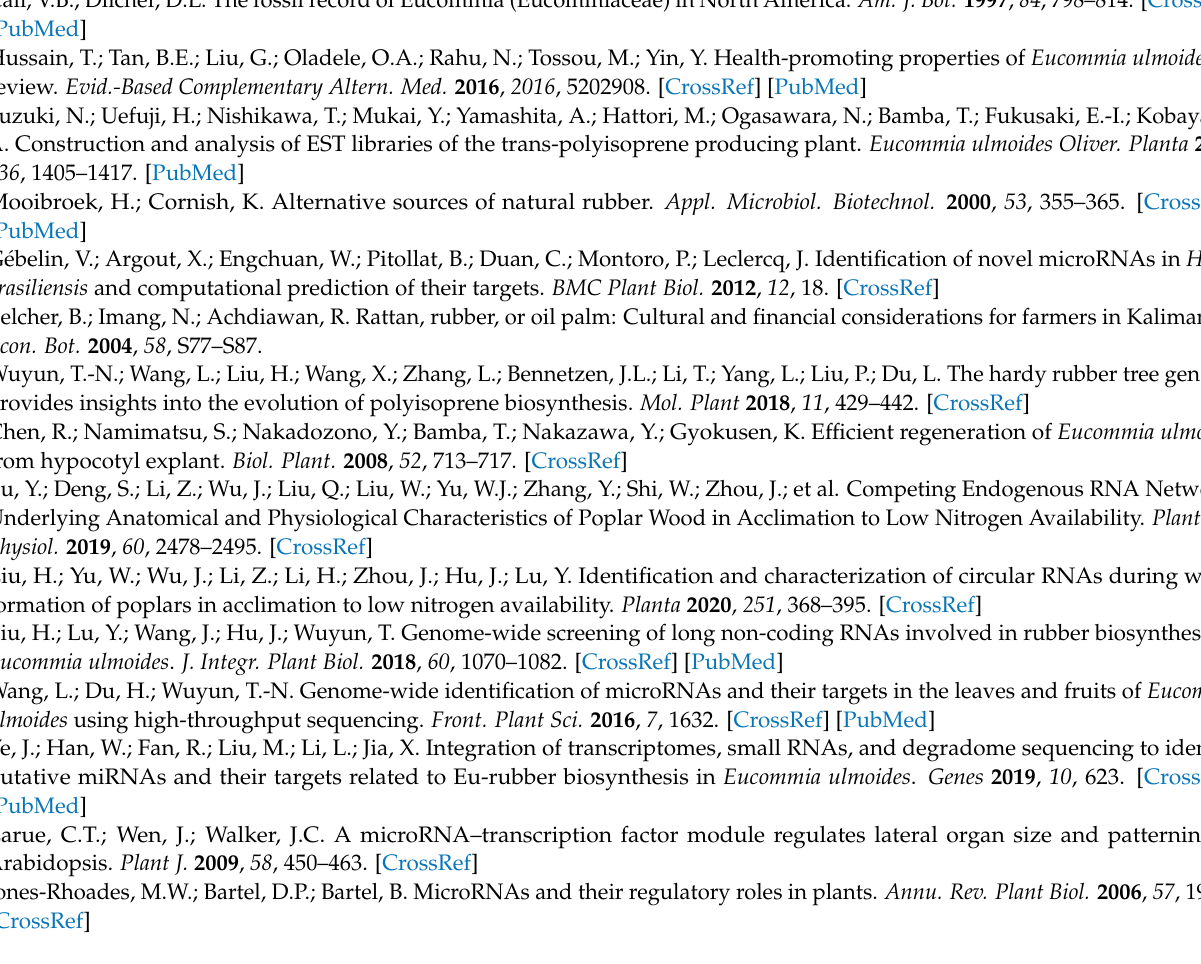
vs. GB511; Table S13: LncRNA − miRNA − mRNA networks identified in GZ511 vs. GZ611. LncRNAs and genes targeted by the same miRNA are lighted by the same color module; Table S14: 229 genes in the lncRNA − miRNA − mRNA networks of GZ511 vs. GZ611, and their homologous A. thaliana gene IDs; Table S15: GO enrichment of genes in the lncRNA − miRNA − mRNA networks (GZ511 vs.